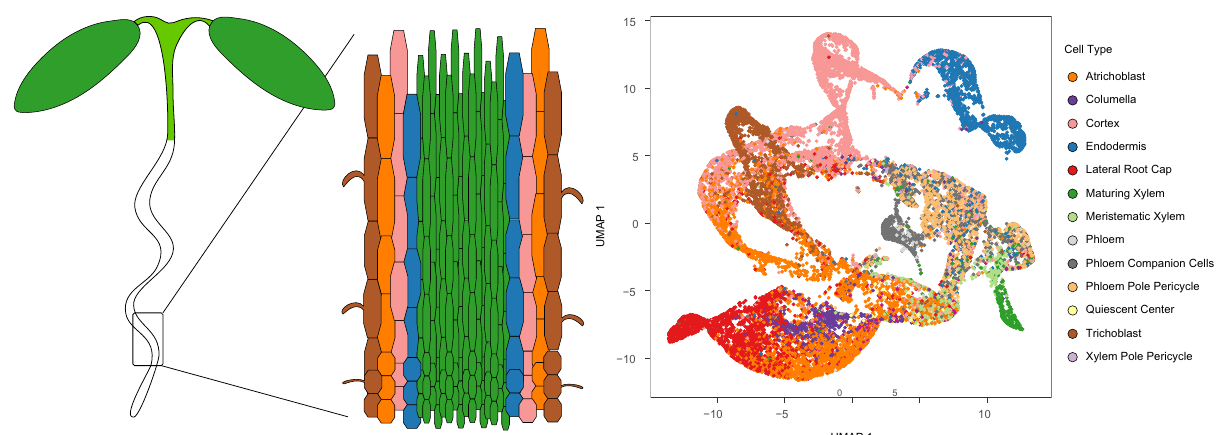
Fig. 1 scRNA-seq of Arabidopsis root. Root development has recently been extensively characterized at the single-cell level in a series of scRNA-seq studies of root cell protoplasts. These methods can con fi dently identify all major cell types within roots and can begin to shed light on developmental trajectories that underlie root growth. Left, cartoon of generic plant root with different cell layers colored by their major cell type. Right, schematic of single- cell transcriptome data from